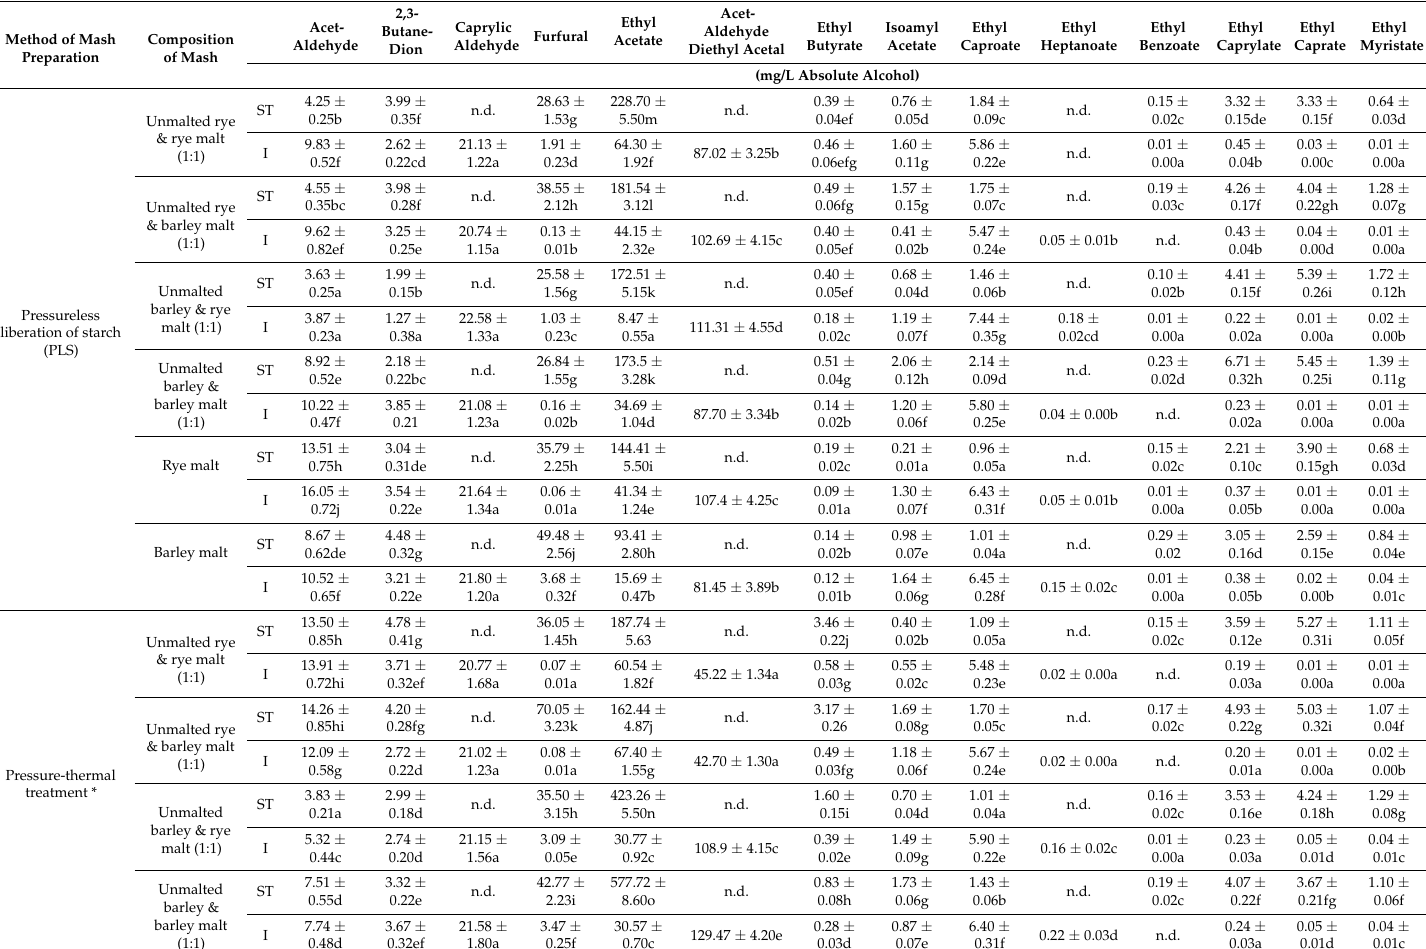
Table 4. Concentrations of carbonyl compounds and esters in the obtained agricultural